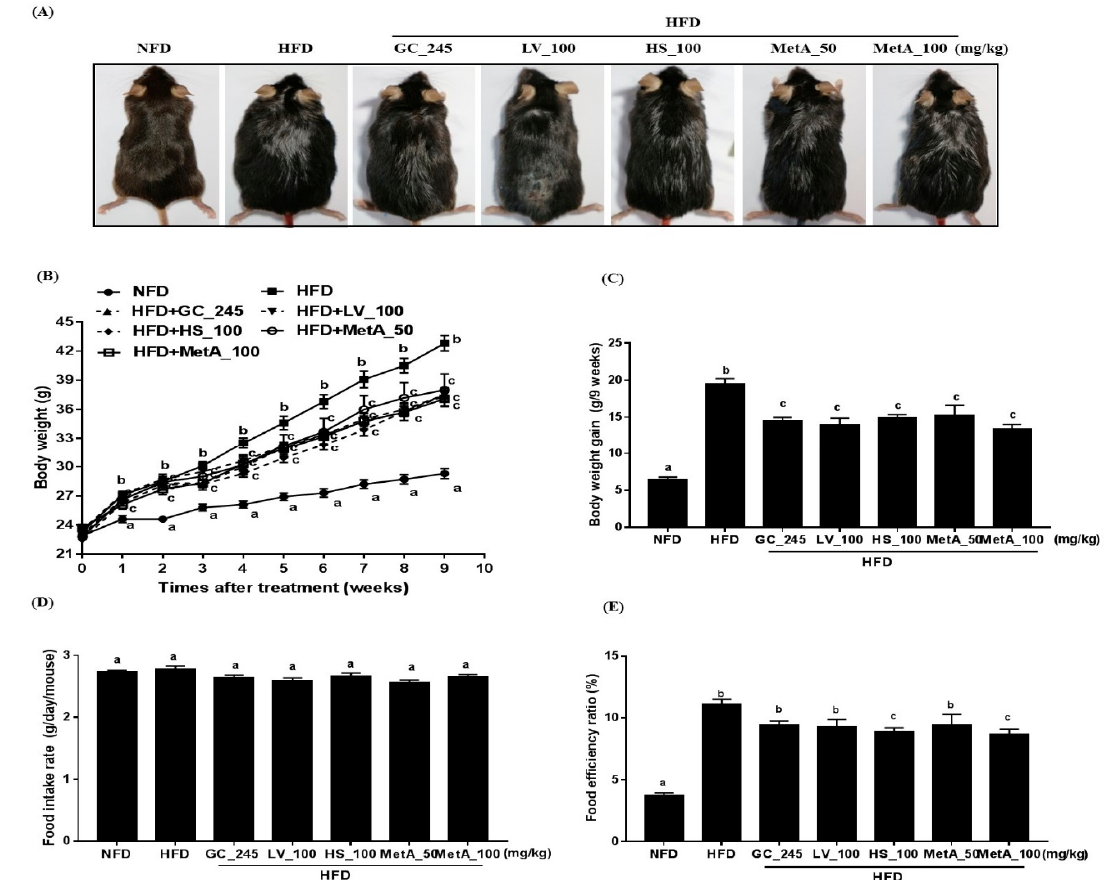
Figure 2. Effect of lemon verbena (LV), Hibiscus flower (HS), and their combination (MetA) on body weight and food intake in high-fat-diet (HFD)-induced obese mice. Changes in body size ( A ), body weight ( B ), body weight gain ( C ), food intake ( D ), and food efficiency ratio (FER, %, E ) of normal diet group (NFD) and high fat diet-induced obese(DIO) mice after 9 weeks of 60% HFD feeding. HFD, 60% high-fat-diet control group; HFD + GC_245, HFD contains Garcinia cambogia extract (245 mg/kg)-fed group; HFD + LV_100, HFD contains lemon verbena extract (100 mg/kg)-fed group; HFD + HS_100, HFD contains Hibiscus flower extract (100 mg/kg)-fed group; HFD + MetA_50, HFD contains the MetA-mixed extract of lemon verbena plus Hibiscus flower (50 mg/kg)-fed group; HFD + MetA_100, HFD contains the MetA-mixed extract of lemon verbena plus Hibiscus flower (100 mg/kg)-fed group. Values are means ± SEM ( n = 10). a–c Values within arrow with different letters are significantly different from each other at p < 0.05 as determined using Turkey’s multiple-range test.